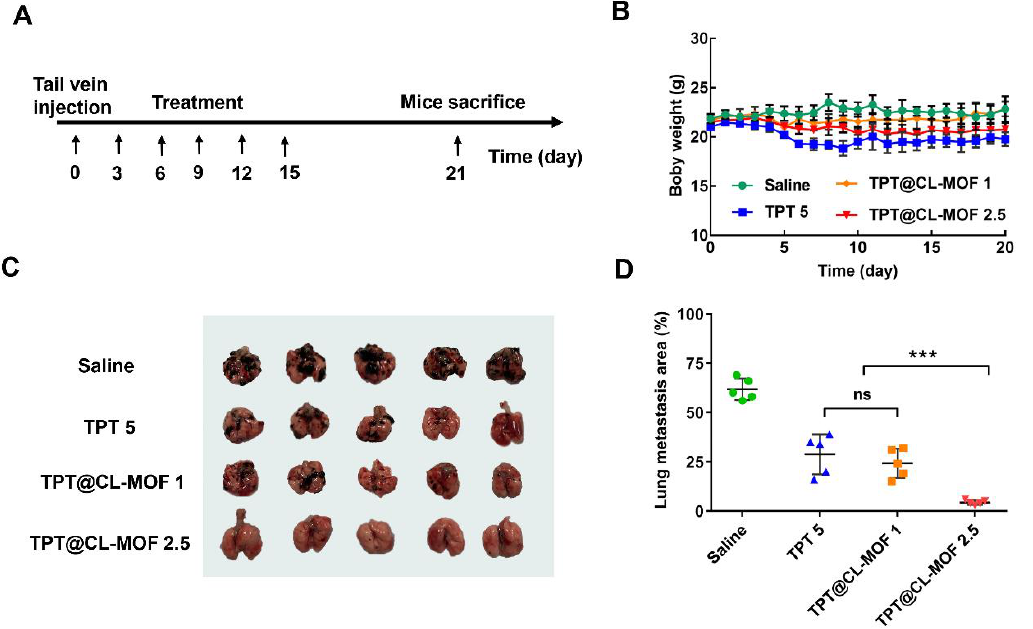
Figure 5. Therapeutic activity of TPT@CL-MOF against B16F10 melanoma lung metastases. ( A ) Di- agram of dosing regimen. ( B ) Body weight of mice receiving different treatments. ( C ) Photographs of lungs isolated from mice bearing B16F10 lung tumor after different treatments ( n = 5). ( D ) Lung metastasis foci area from mice bearing B16F10 lung tumor after different treatments. TPT@CL-MOF 1 and TPT@CL-MOF 2.5 denotes TPT at 1 mg/kg and 2.5 mg/kg, respectively. *** p < 0.001. The abbreviation “ns” indicates no significant difference between relevant treatment groups.